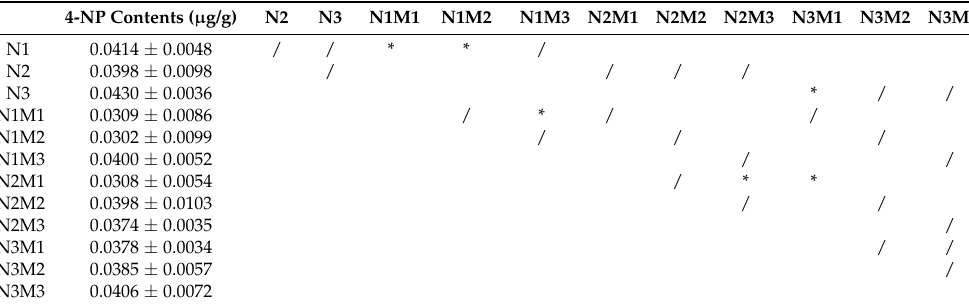
Table 11. Statistical analysis of 4-NP contents in gill at Day 30.